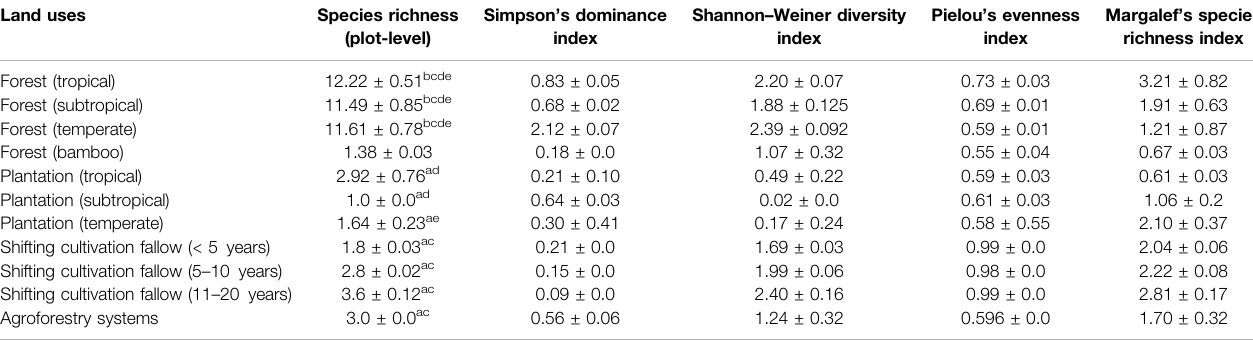
TABLE 1 | Species richness and diversity indices of the tree species across different land-use sectors of Northeast India. Land